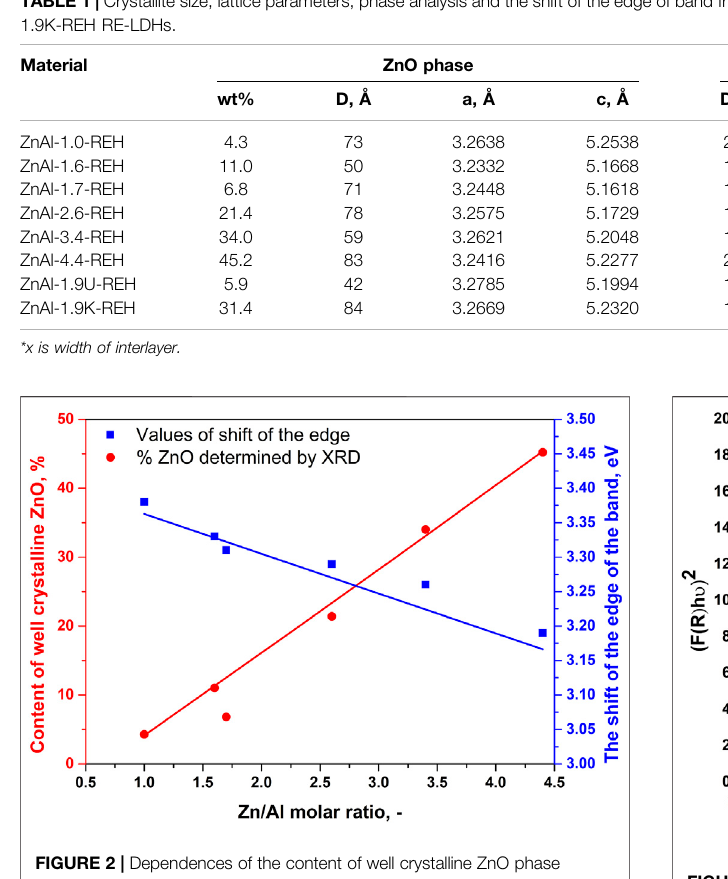
FIGURE 3 | Recalculated DR spectra of ZnAl-X-REH reconstructed materials, ZnAl-1.9U-REH and